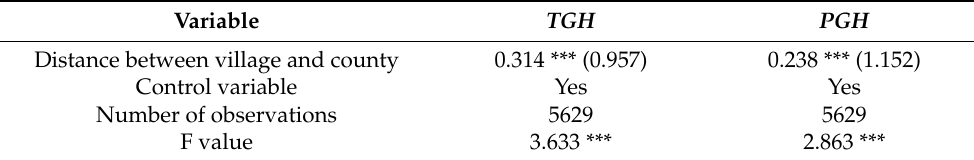
Table 8. Estimation of the instrumental variable of rural households’ part-time farming and grain output (2SLS). Variable TGH PGH Distance between village and county 0.314 *** (0.957) 0.238 *** (1.152) Control variable Yes Yes Number of observations 5629 5629 F value 3.633 *** 2.863